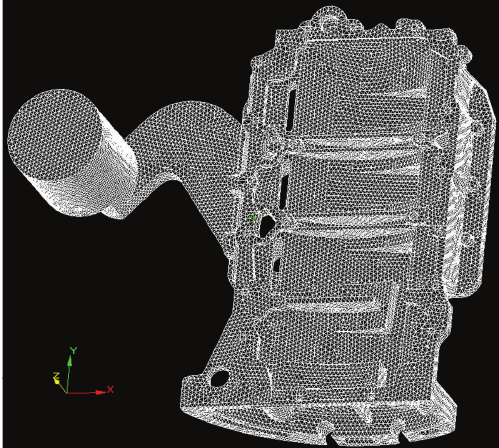
Figure 1: Geometry of ladder frame product.